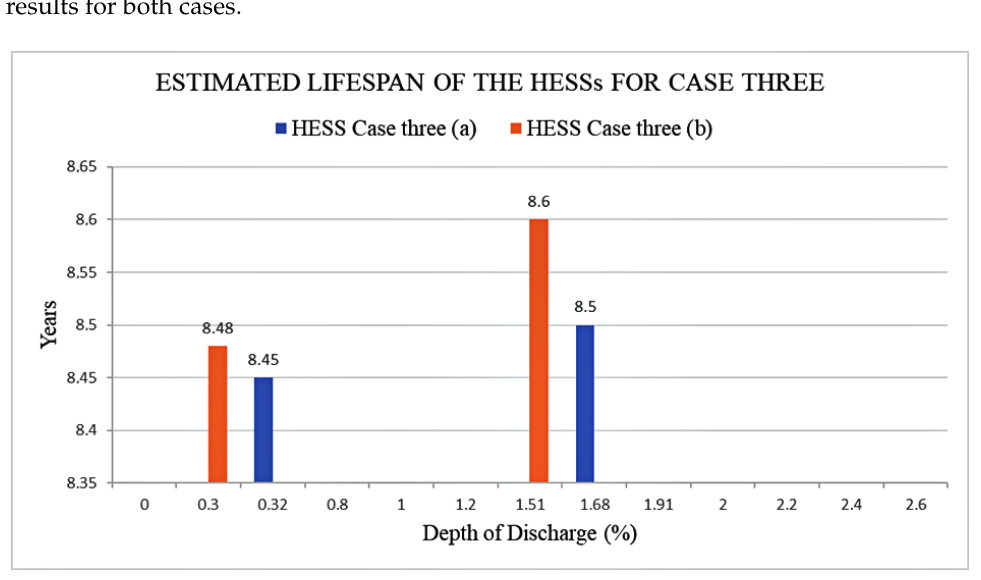
Figure 25. The estimated lifespan of case three (a) versus Case three (b). Table 2. A summary of the HESS case results. Case